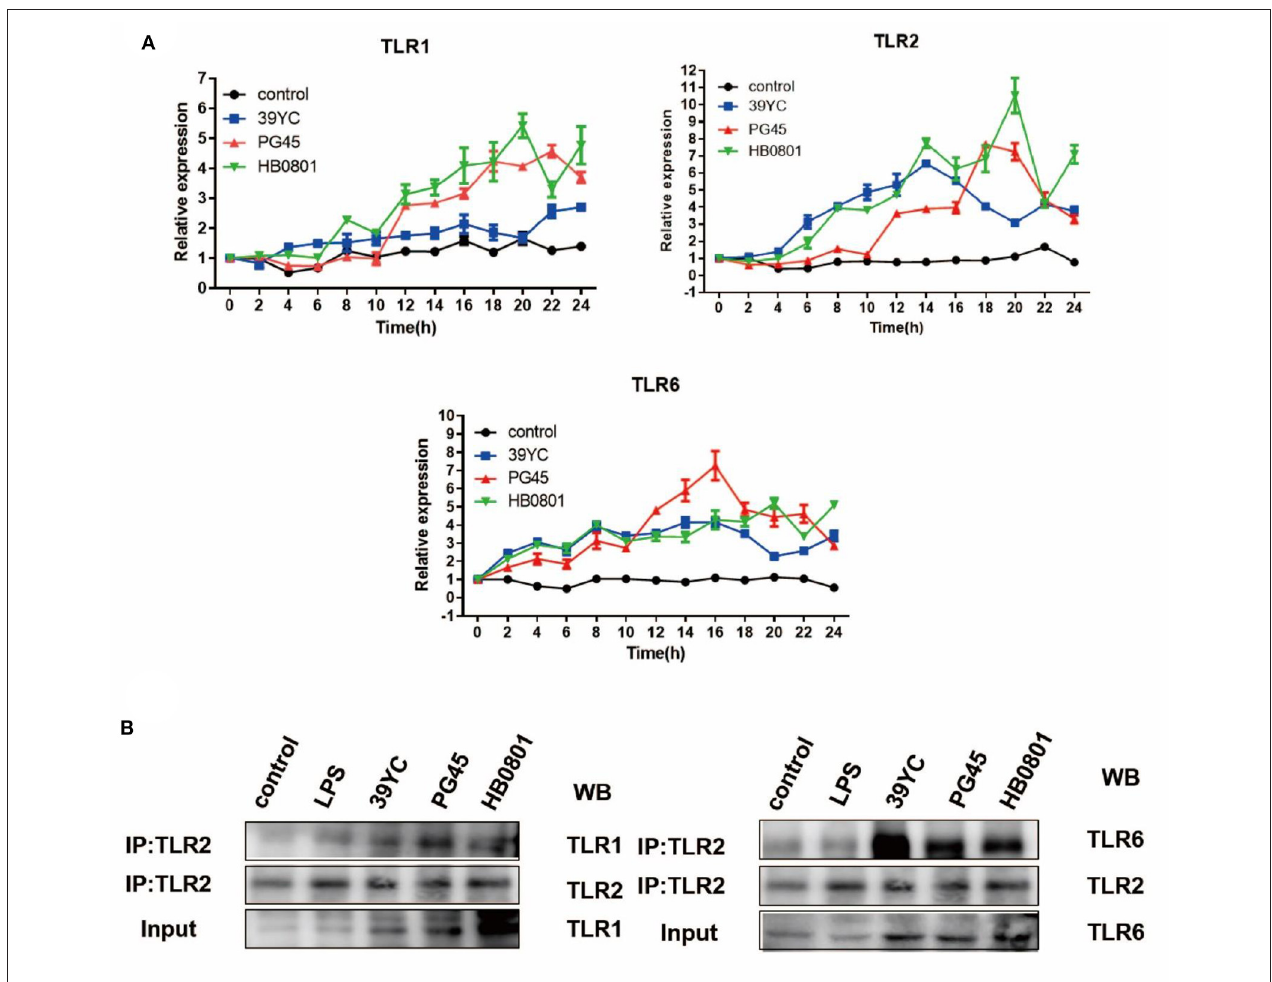
FIGURE 4 | Roles of TLR1/2/6 in BMECs induced by M. bovis. (A) Time-dependent mRNA expression of TLR1, TLR2, and TLR6 after BMECs infected by M. bovis , (B) Co-IP for TLR1/TLR2, TLR2/TLR6 after BMECs infected by M. bovis .